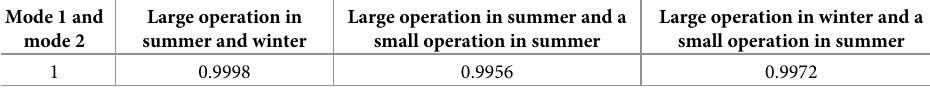
Table 4. The correlation coefficient of active power loss under different operation modes.